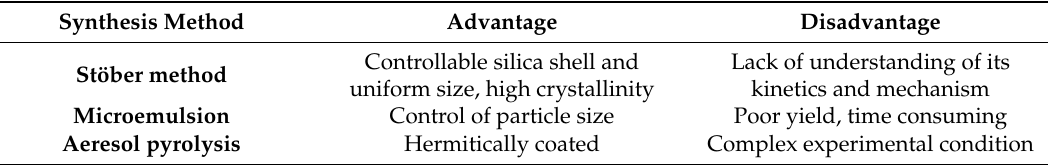
Table 4. Synthesis methods for silica-coated IONPs.